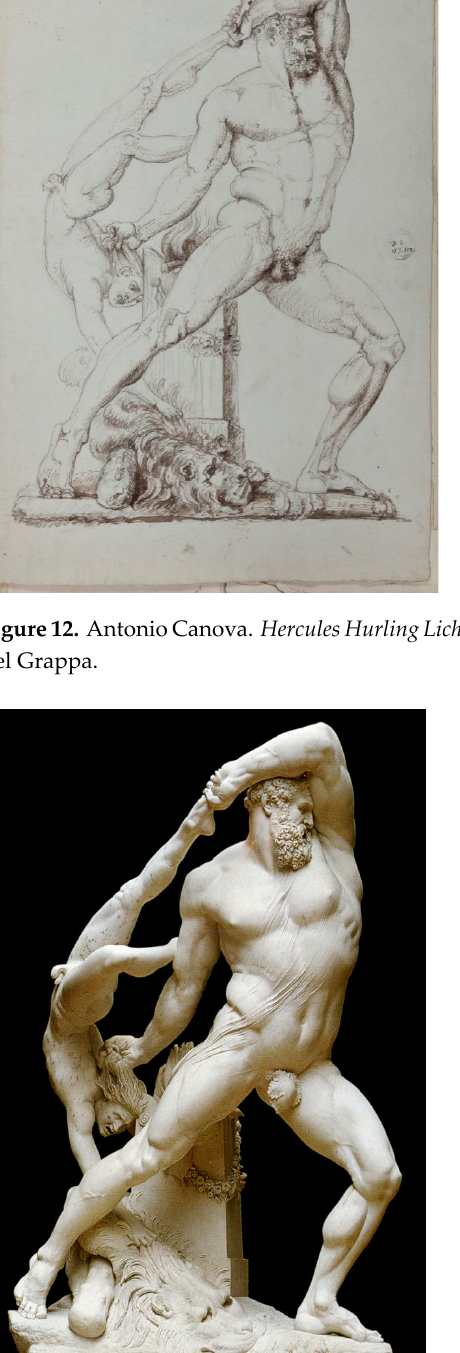
Figure 14. Pavel Sorokin. Hercules and Lichas , 1849. Odesa National Fine Arts Museum.